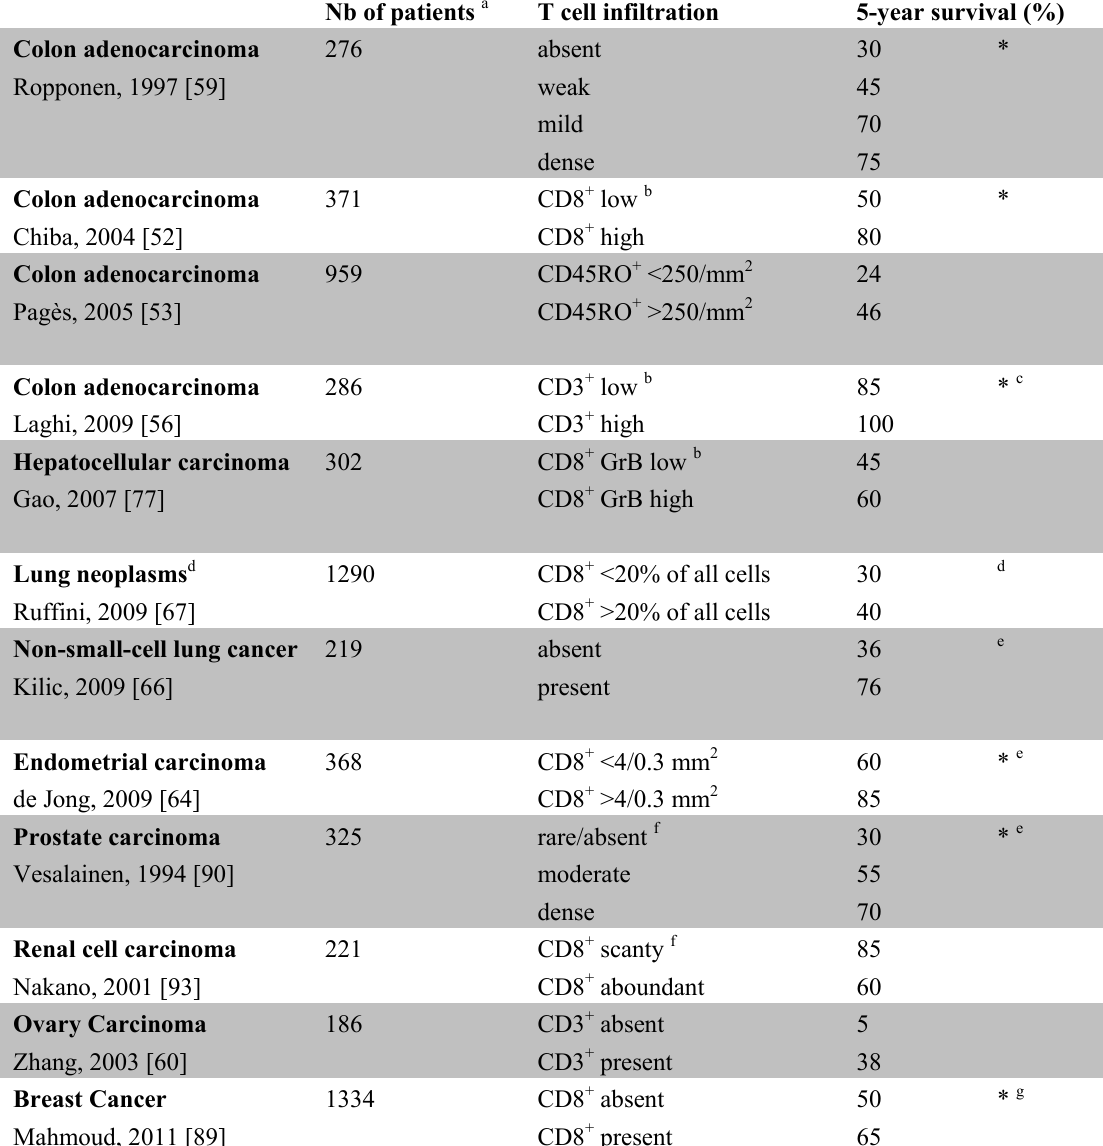
Table 2. Patient survival correlates with the presence of TIL in various tumor